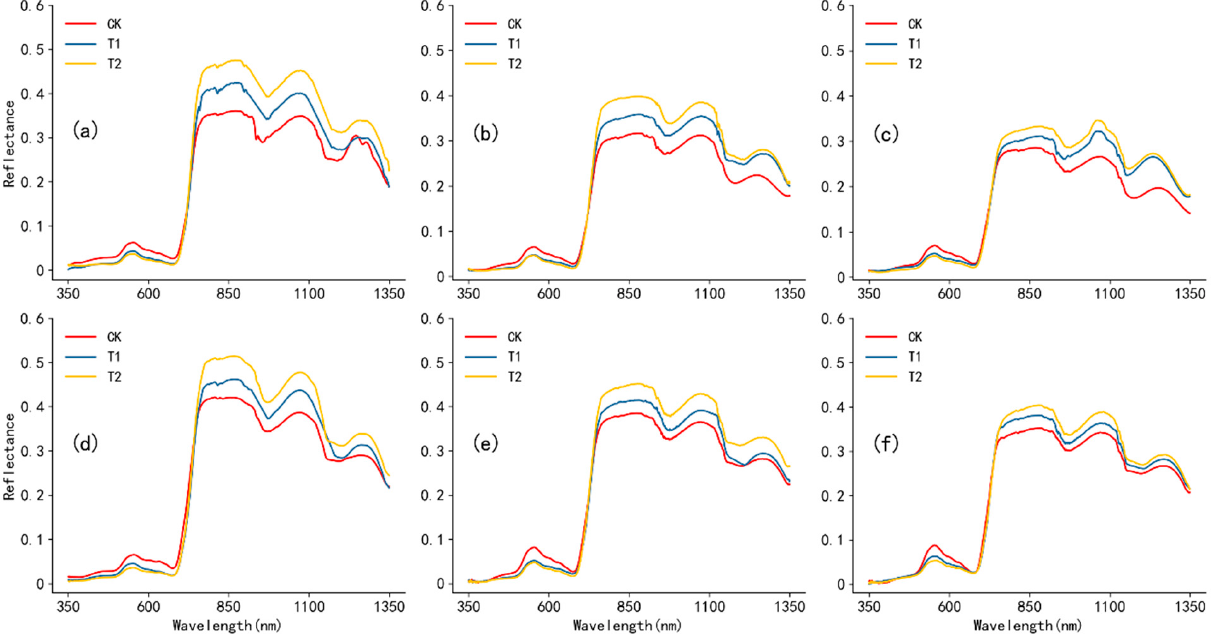
Figure 4. Canopy spectra curves of rice between different treatments: ( a – c ) are DAH 14d, DAH 21d, and DAH 28d in 2016; ( d – f ) are DAH 14d, DAH 21d, and DAH 28d in 2017.